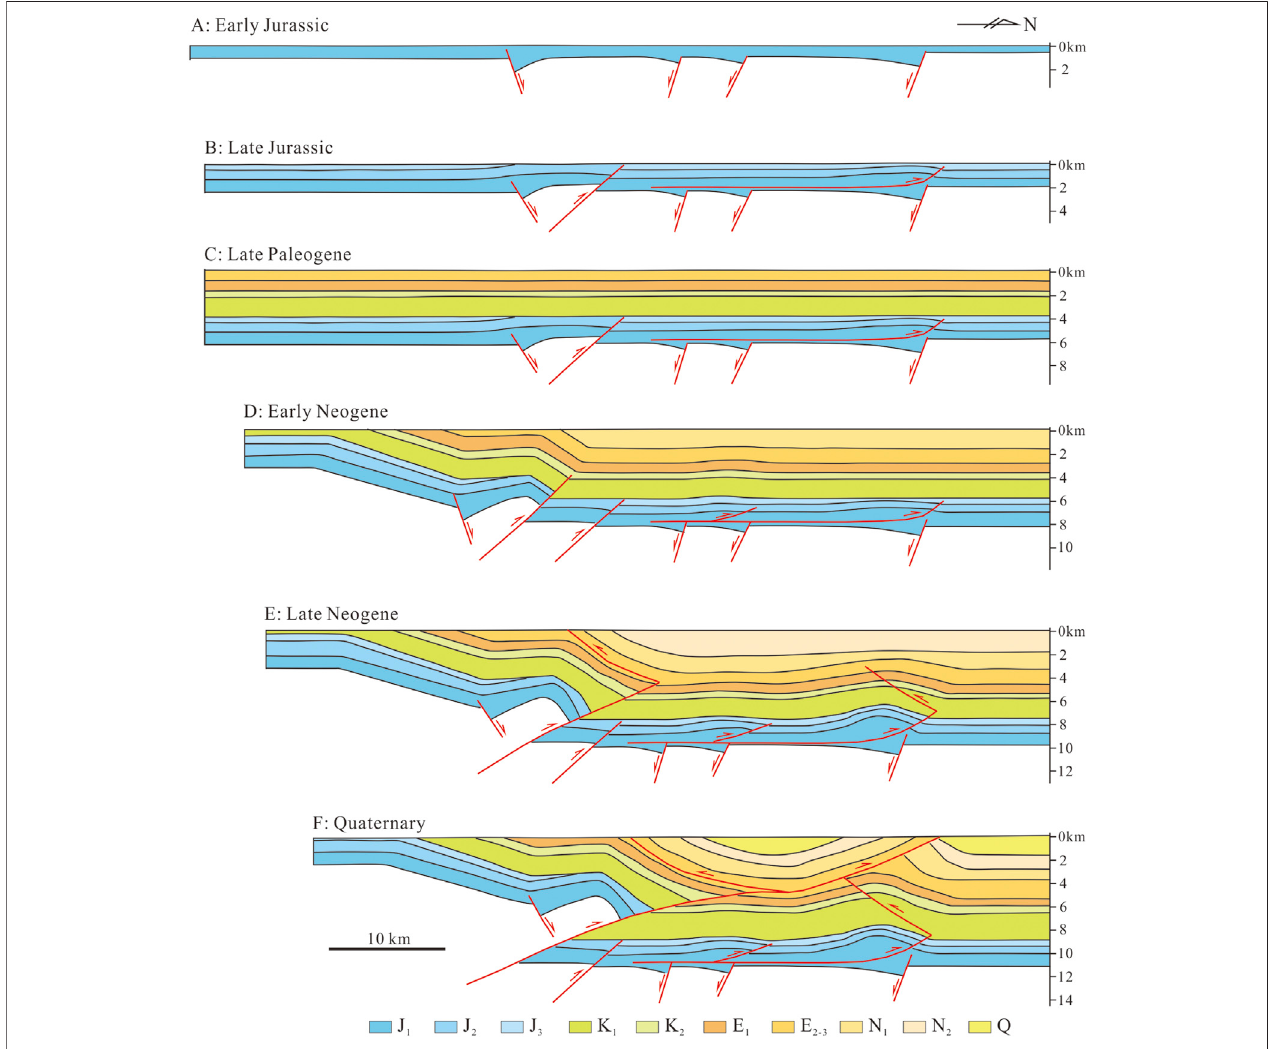
FIGURE 10 | Structural evolution of the Southern Junggar fold-and-thrust belt. The fi rst compressional stage occurred in the Late Jurassic (B) , and the second compressional stage occurred in the Late Cenozoic (D – F) .